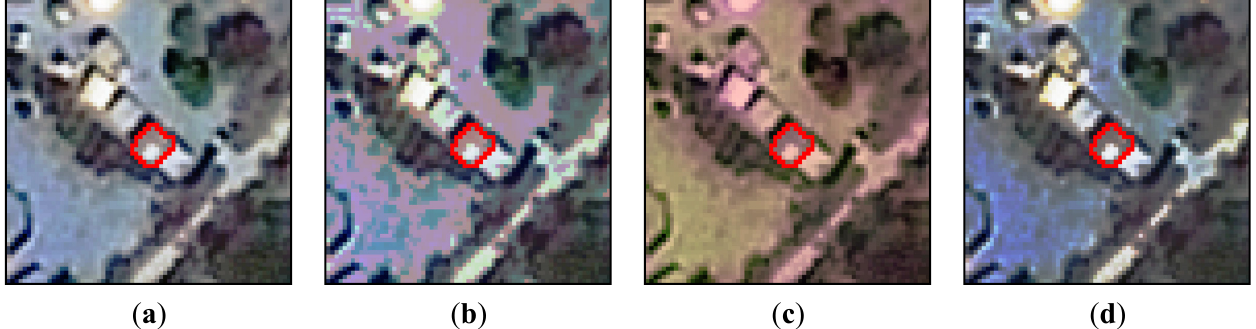
Figure 5. Example output of the three used mapping functions on an arbitrary test image ( a ). Parameters were assigned random values. The red polyline denotes an example element of interest; ( b ) shows output of the SS function (note the creation of sharp gradients);( c ) shows output from the transformation matrix, while ( d ) shows the output from the GT function. Note the non-linear stretch of the output from the GT